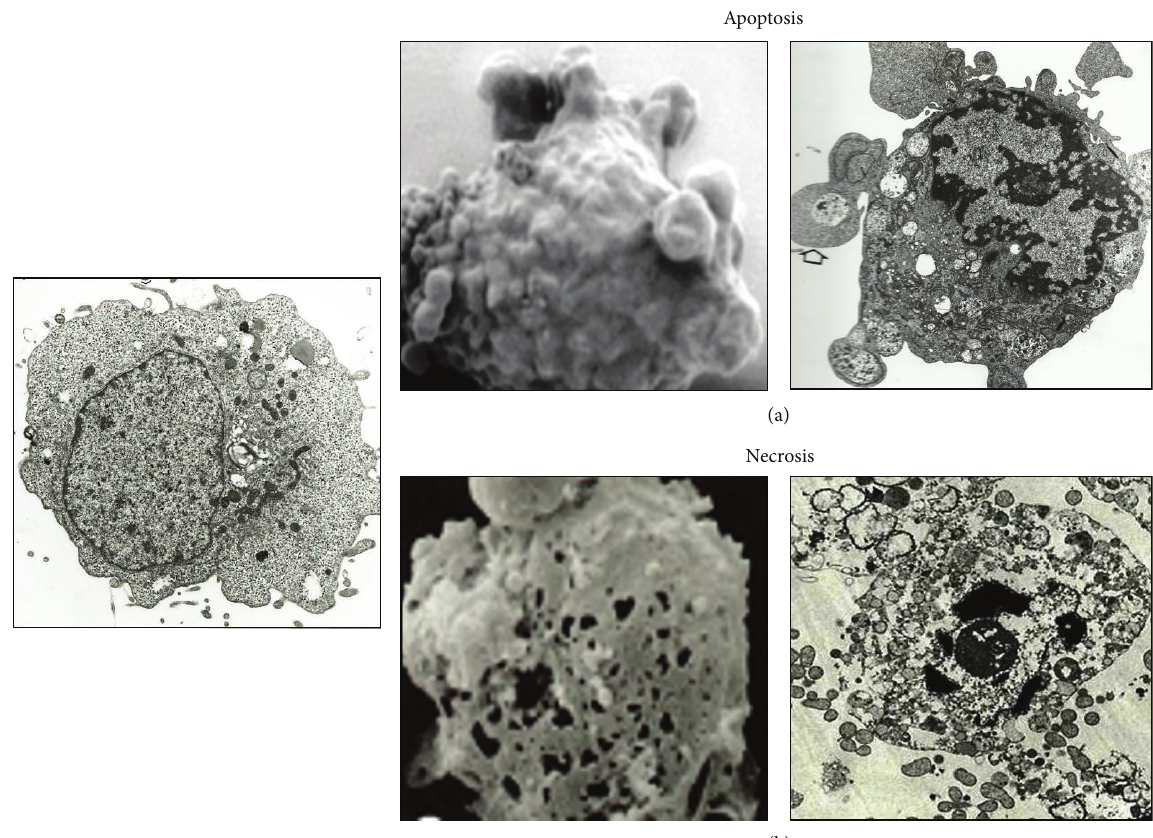
Figure 1: Distinct morphological features of apoptosis and necroptosis. (a) Apoptosis is characterized by cell shrinkage, membrane blebbing condensation, margination of nuclear chromatin, and packaging of apoptotic bodies and its engulfment by neighbor cells. (b) Necroptosis is characterized by the increase in cell volume, swelling of organelles, perforation of plasma membrane, cellular collapse, and release of cellular